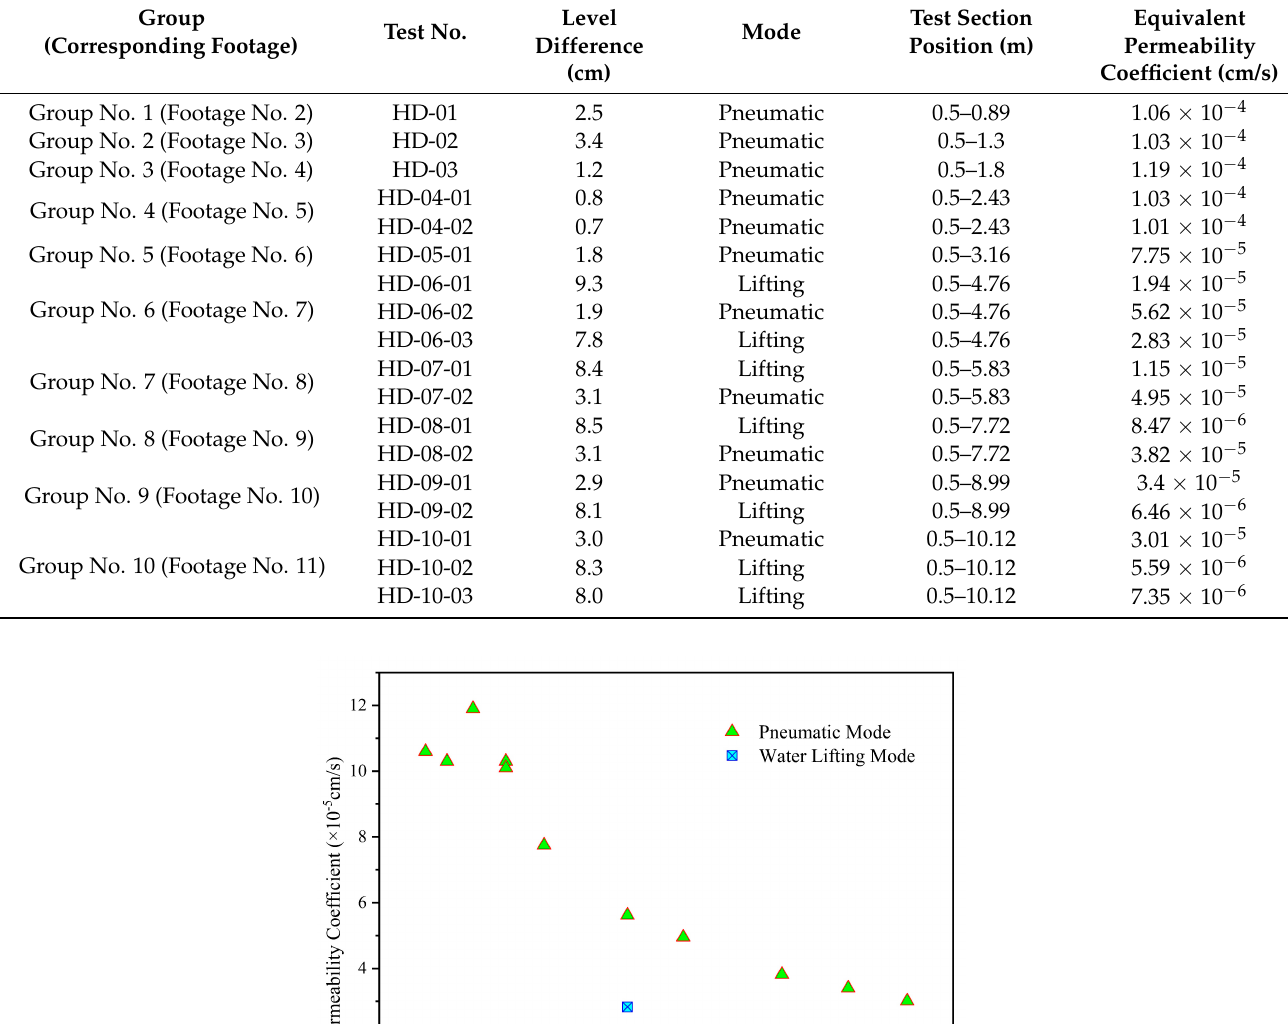
Table 4. Calculation result statistics of slug tests.